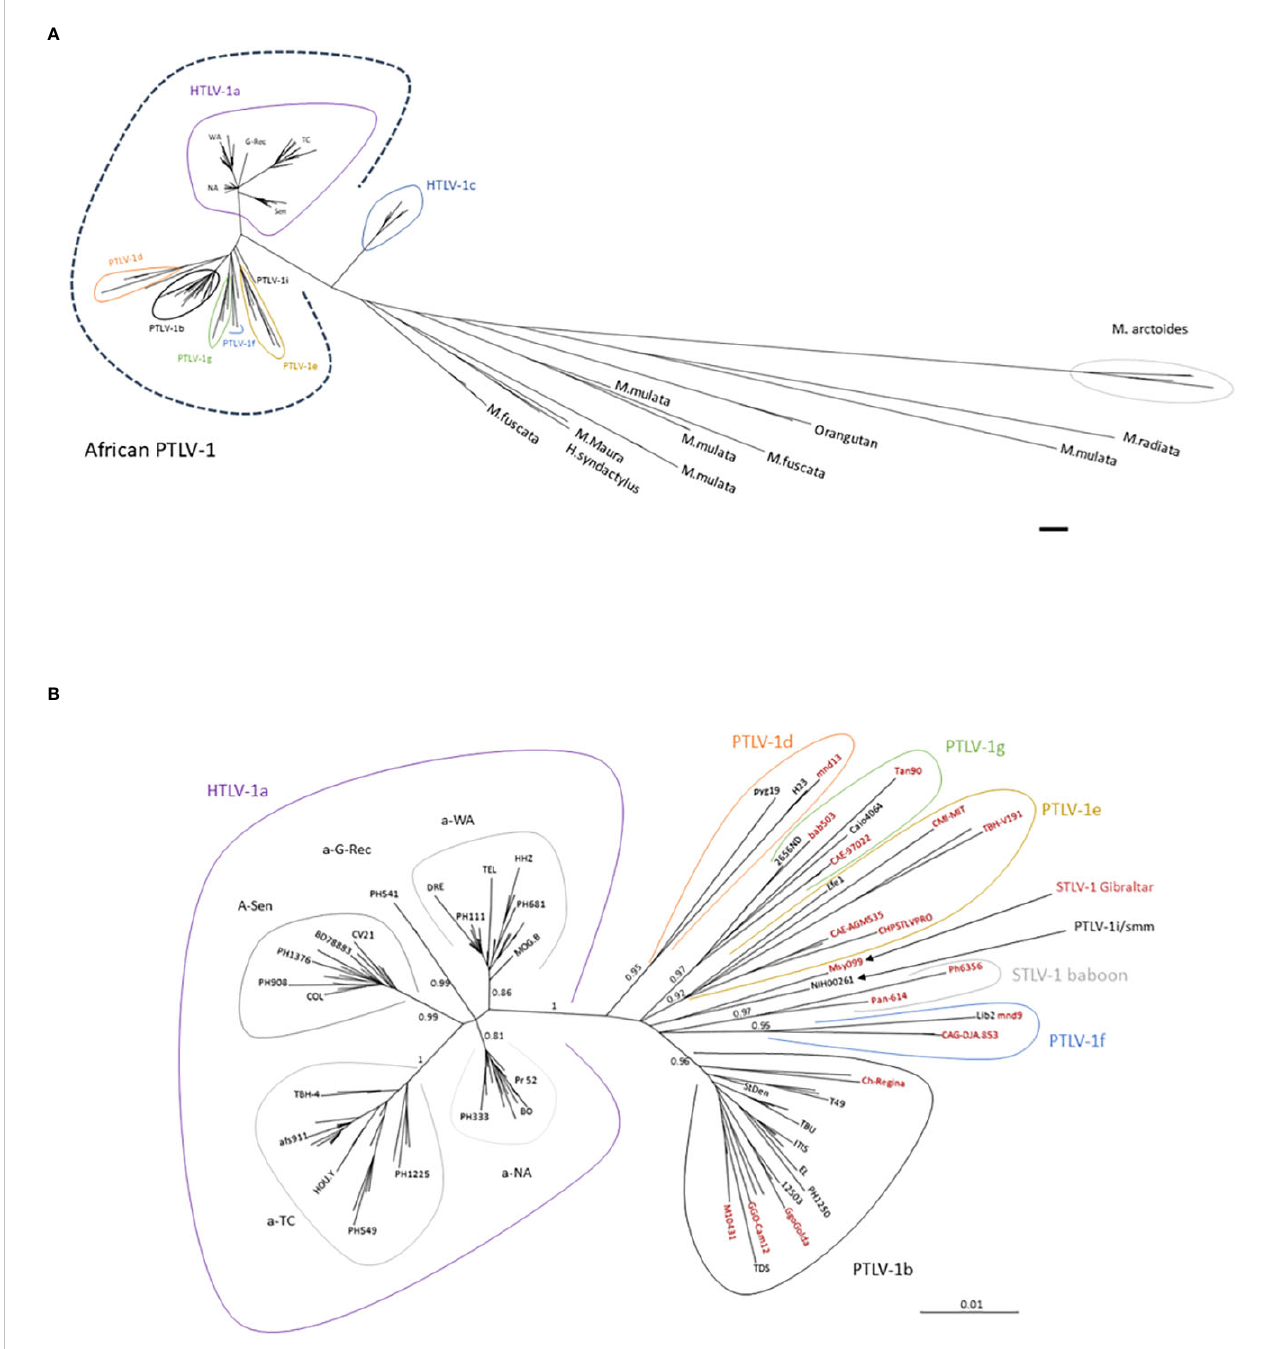
FIGURE 9 (A) General disposition of African PTLV-1 among the other PTLV-1. Phylogenetic tree generated from a 711-nucleotide long alignment of 196 sequences. Sequences comprise African PTLV-1, Australo-Melanesian HTLV-1c and Asian Macaque STLV-1 strains. The phylogenetic tree was generated using the Maximum Likelihood method. The scale bar represents nucleotide substitutions per site. (B) Phylogenetic tree presenting the genetic diversity of African PTLV-1. The analysis was performed on an alignment of 125 HTLV-1 and 30 STLV-1 sequences (presented in black and red respectively). This alignment contains distinct African HTLV-1 full-length LTR sequences (in black), and the most representative STLV-1 full-length sequences (in red). The size of the complete LTR available in GenBank varies between 745-nt and 790-nt depending on the strain, resulting in an alignment of 772-nt nucleotides (due to dif fi culties in aligning some regions). The phylogenetic tree was derived by the neighbor-joining method using the GTR model (gamma=0.5017), with the PAUP software. Horizontal branch lengths are drawn to scale, which is indicated by the bar. The topology of the phylogenetic tree was validated by Maximum Likelihood (using the SeaView5 software), and the strength of the branches was estimated using approximate likelihood-ratio test (aLRT). The values correspond to the calculated probability. The de fi nition of genotypes (or subtypes of PTLV-1) depends on the number of sequences present for each group, and the size of the sequences. The historically coined “ South African and East African STLV-1 ” subgroup (219) is now presented as part of the PTLV-1e genotype. Similarly, the “ Central and West Africa STLV-1 ” subgroups now belong to the HTLV-1g genotype. All genotypes represented in Africa are presented in the tree, except HTLV-1h (as described by Lie ́ geois (220), for which only partial LTR sequences are available. HTLV-1a is strictly present in humans, STLV-1 Gibraltar and STLV-1 baboon have never been detected in humans. All the other subgroups have been identi fi ed both in human and simian